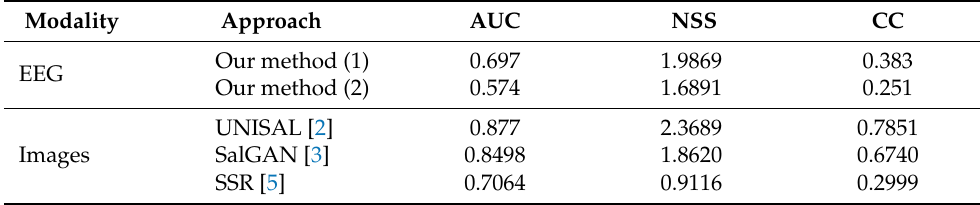
Table 3. Comparison of our approach results with the state-of-the-art works for saliency map estimation. In the upper part of the table, our approach with our dataset is presented, and in the lower part, different models results on the MIT300 dataset [31] are shown. We presented in this table the results of two approaches: (1) the global model composed of a Generator and Discriminator, (2) a model composed only by the